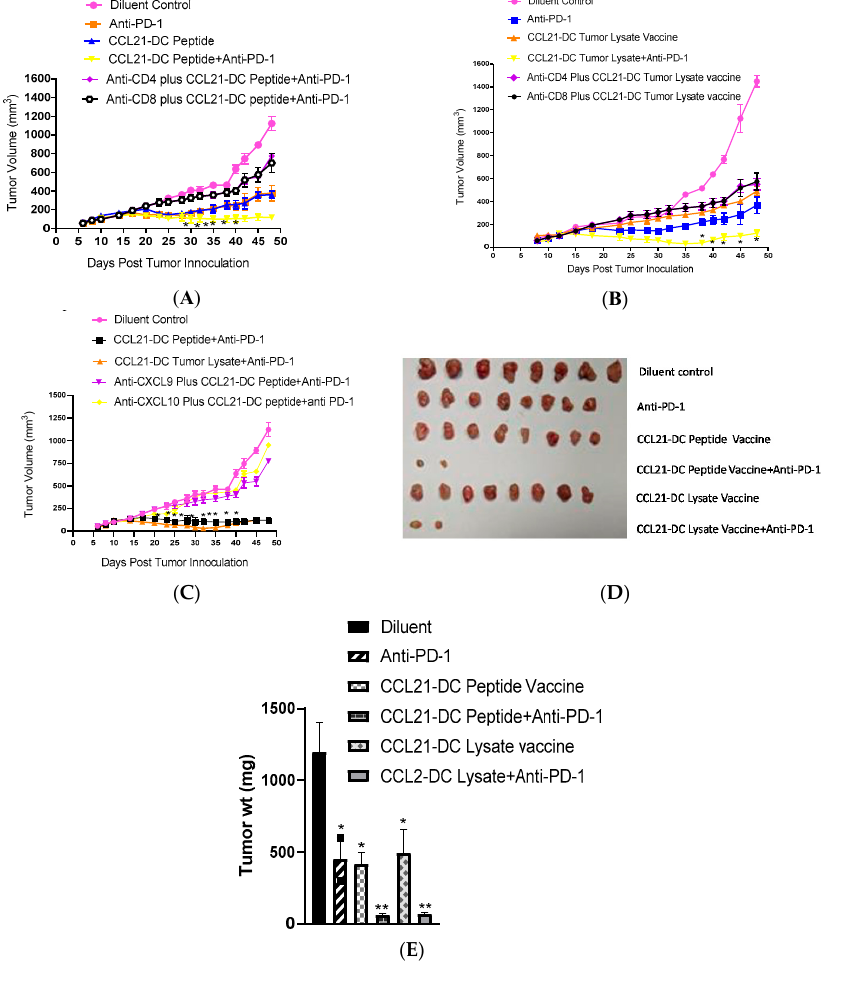
Figure 1. Combined therapy significantly inhibited tumor growth in comparison to monotherapy and the effects of therapy were CD4 T and CD8 T cell dependent ( A,B,D,E ). Depletion of CXCL9 and CXCL10 abrogated the anti-tumor activity of combined therapy ( C ). CCL21-DC peptide vaccine administered prior to combined therapy led to 100% tumor radication. Around 10% of the cured mice had a tumor recurrence 4 weeks following tumor eradication (Table 1).